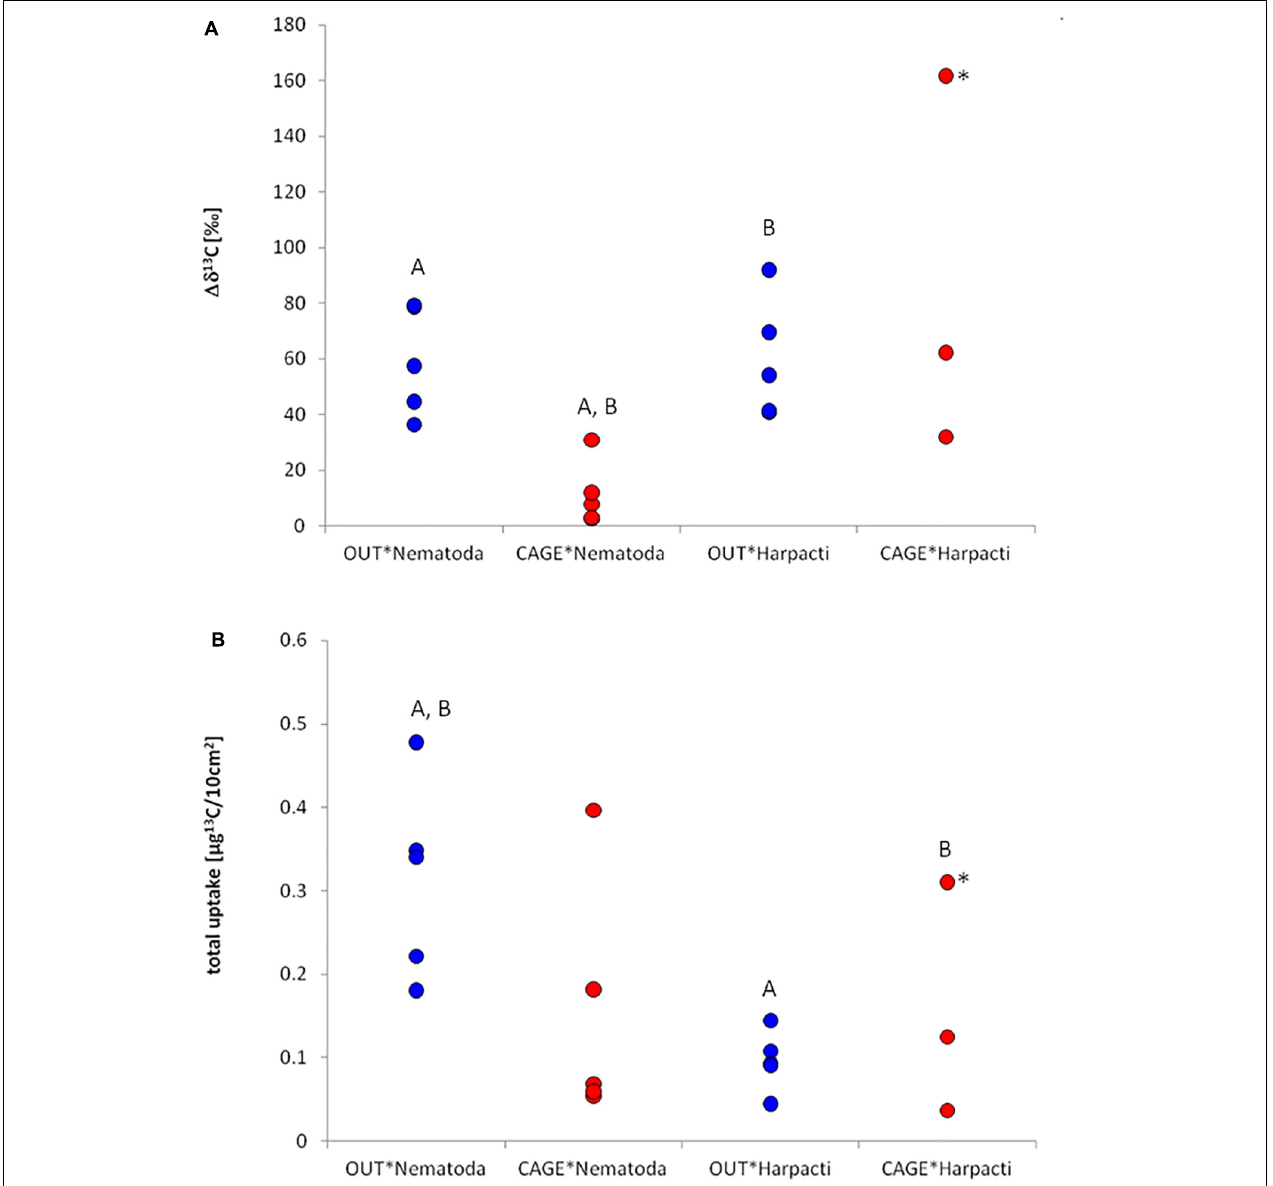
FIGURE 4 | Specific uptake (A) and incorporation of 13 C (B) in different meiofauna taxa under the fish farm (CAGE*) and at the reference site (OUT*). Actual values are given for (A) and an estimation of biomass has been made for (B) (see section “Materials and Methods”). Significant differences among pairs are marked with the same letter. For the analysis of significance the sample marked with * was omitted as an outlier (see section “Materials and